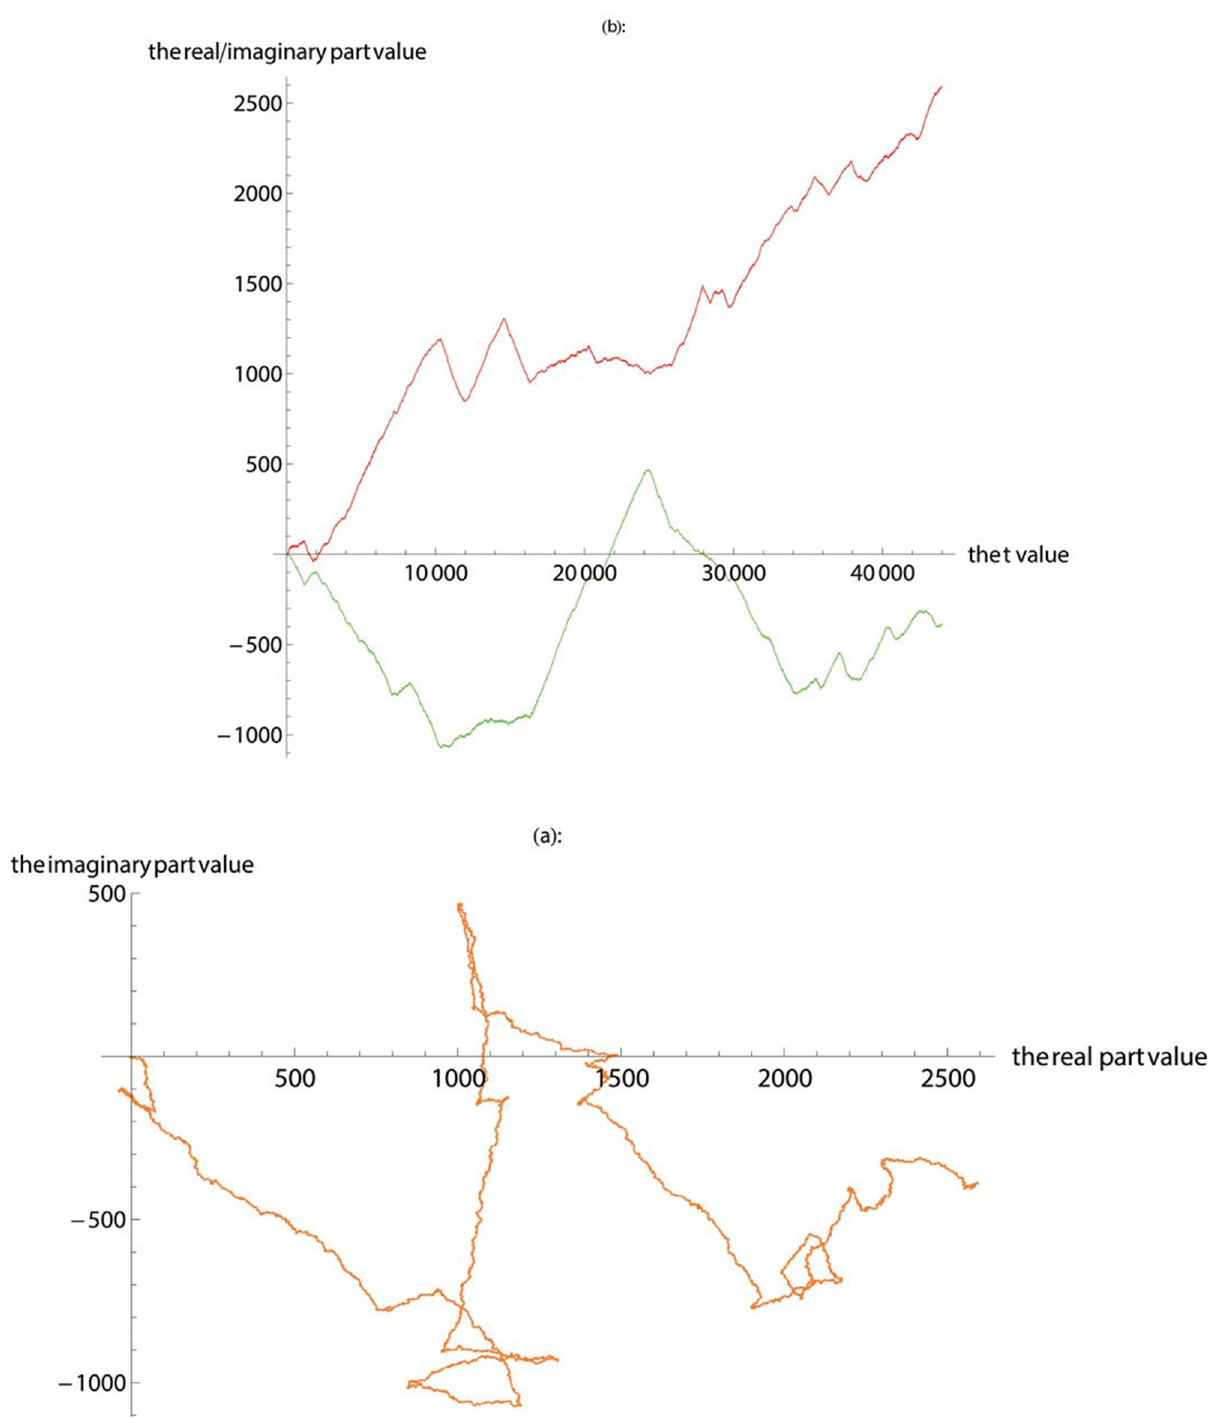
Fig 4. The TP walk of scaffold 21. ( a ) Plot the walk trace in the complex plane. ( b ) Plot the real part (red) and imaginary part (green).